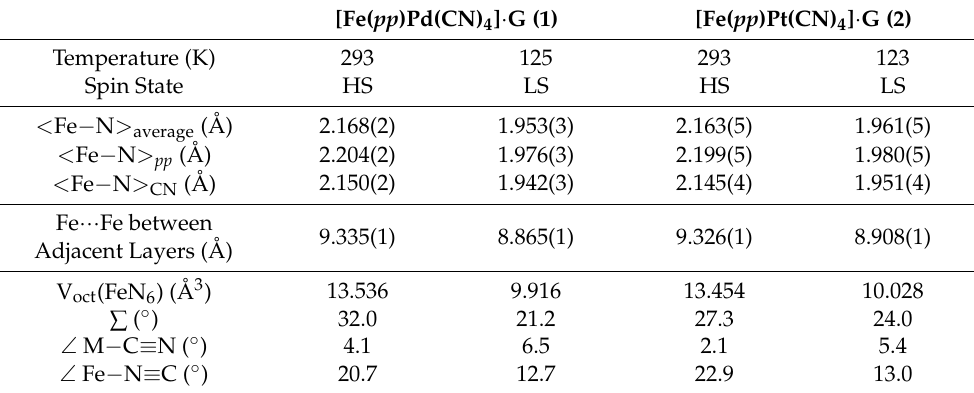
Table 2. Selected structural parameters of 1 and 2